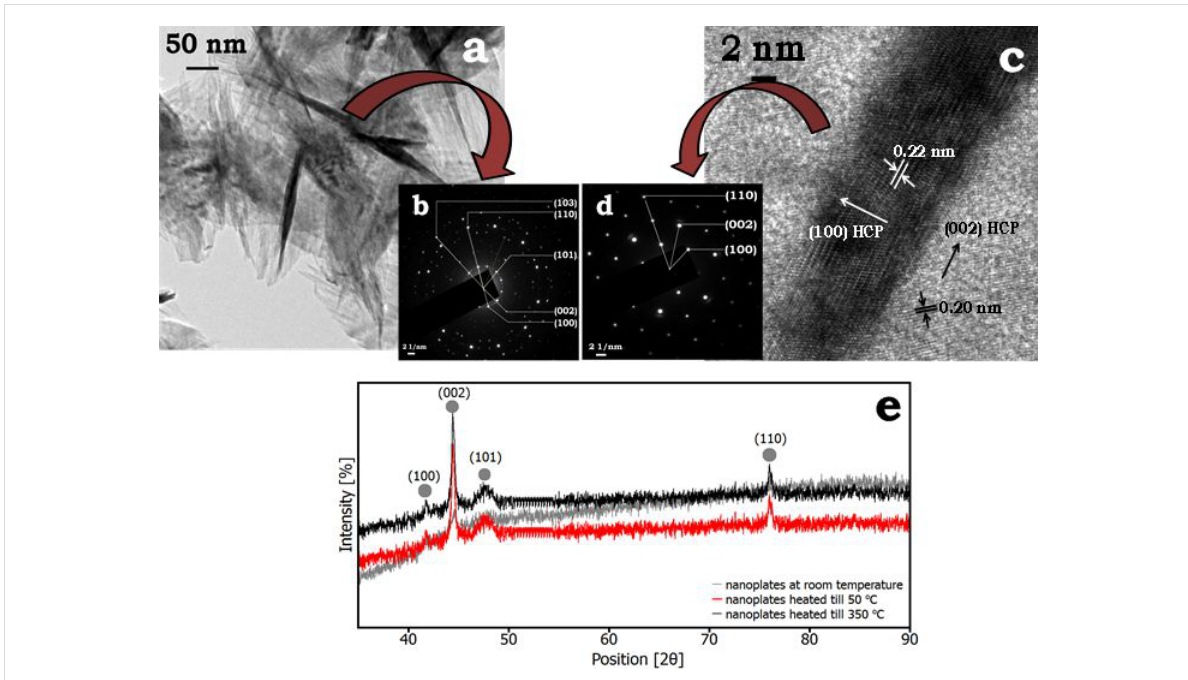
Figure 6: Crystal structure analysis of hierarchical nanoplates. (a,b) A group of nanoplates and the corresponding SAED pattern obtained by an elec- tron beam of 30 nm diameter shows various planes of hcp cobalt; (c,d) high resolution image of a single nanoplate, the edge is normal to the direc- tion of the electron beam, and the obtained SAED pattern at a spot focused with electron beam with 5 nm diameter; (e) XRD spectrum of fully grown cobalt nanoplates (after 120 min).